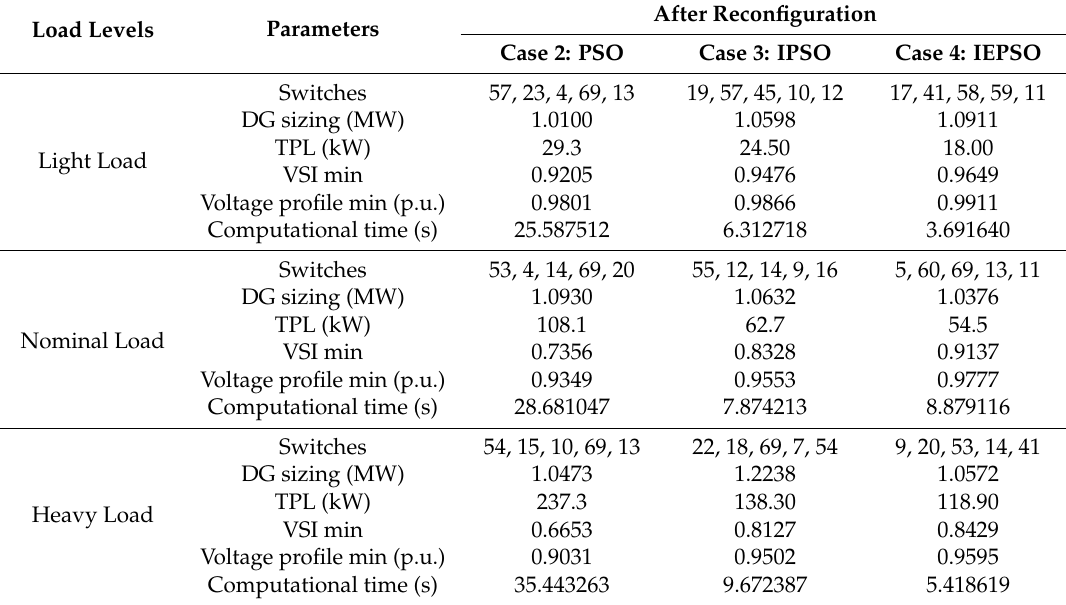
Table 7. The performances of PSO, IPSO and IEPSO for DNR with DG sizing implementation in 69-bus radial distribution